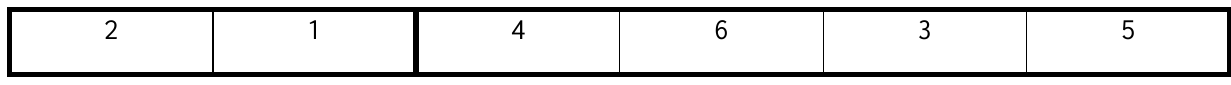
Fig. 8. An instance of the sequence for the proposed